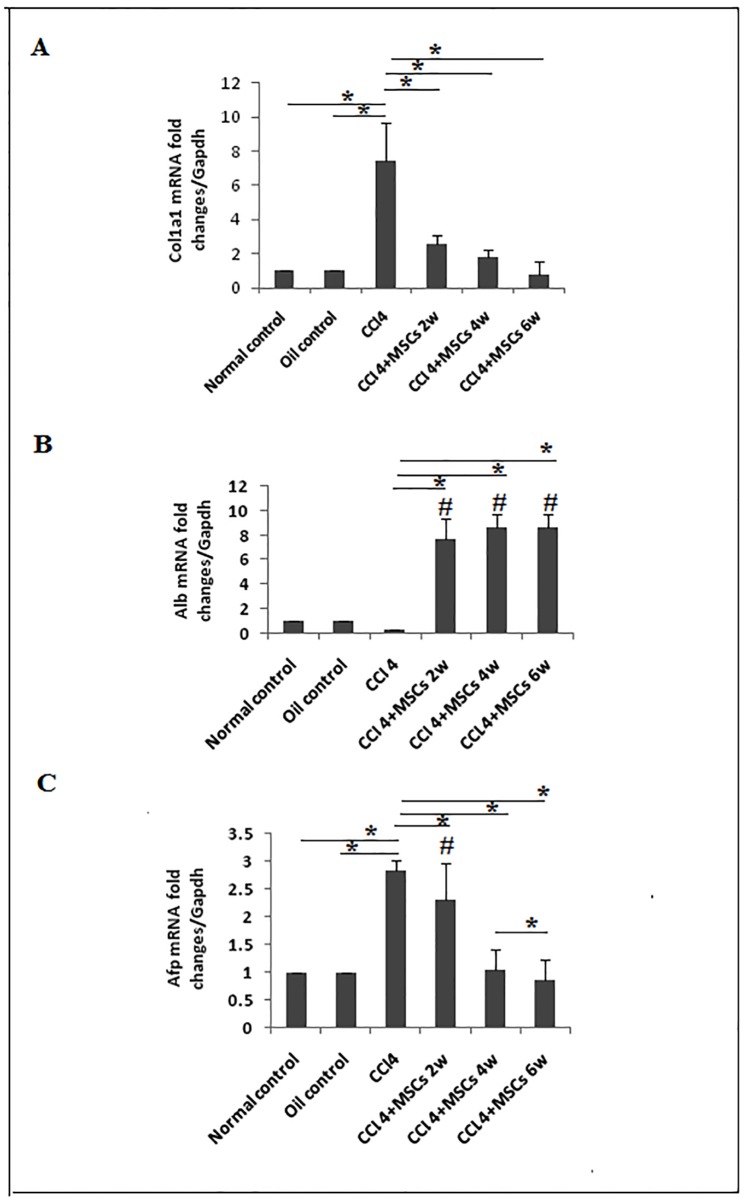
Gene expression of Alb, Afp and Col1a1 in liver tissue.The relative quantification of a. Col1a1, b. Alb, and
c. Afp were carried out utilizing the 2–ΔΔCt ± standard deviation (SD) method and Gapdh gene expression as housekeeping gene. Each experiment was performed in duplicate and results are expressed as fold induction of mRNA expression (n = 5). *P<0.05. #P<0.05 compared to control groups.